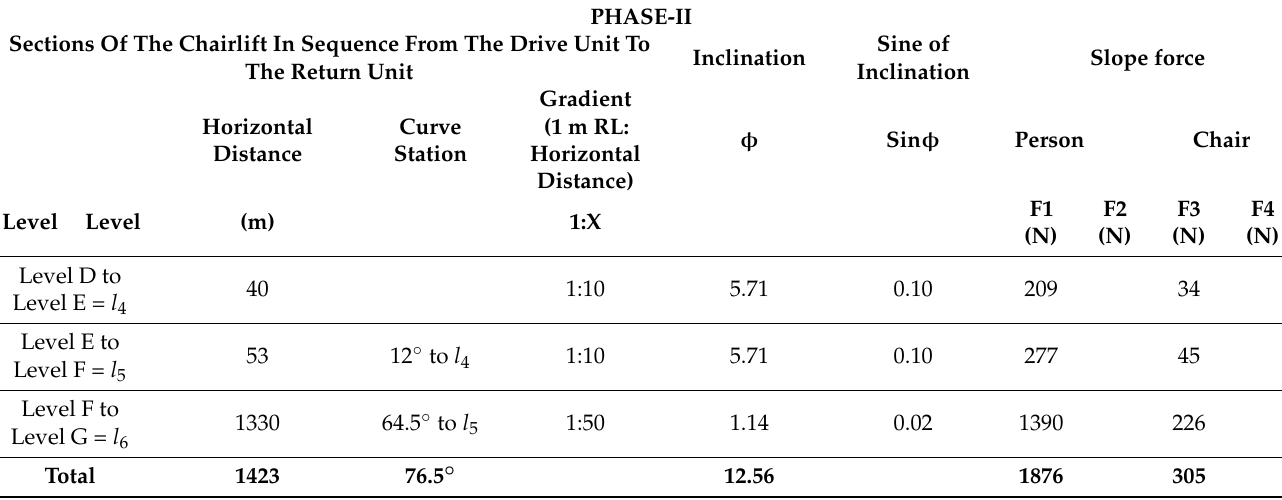
Table 3. Phase II Man-rider